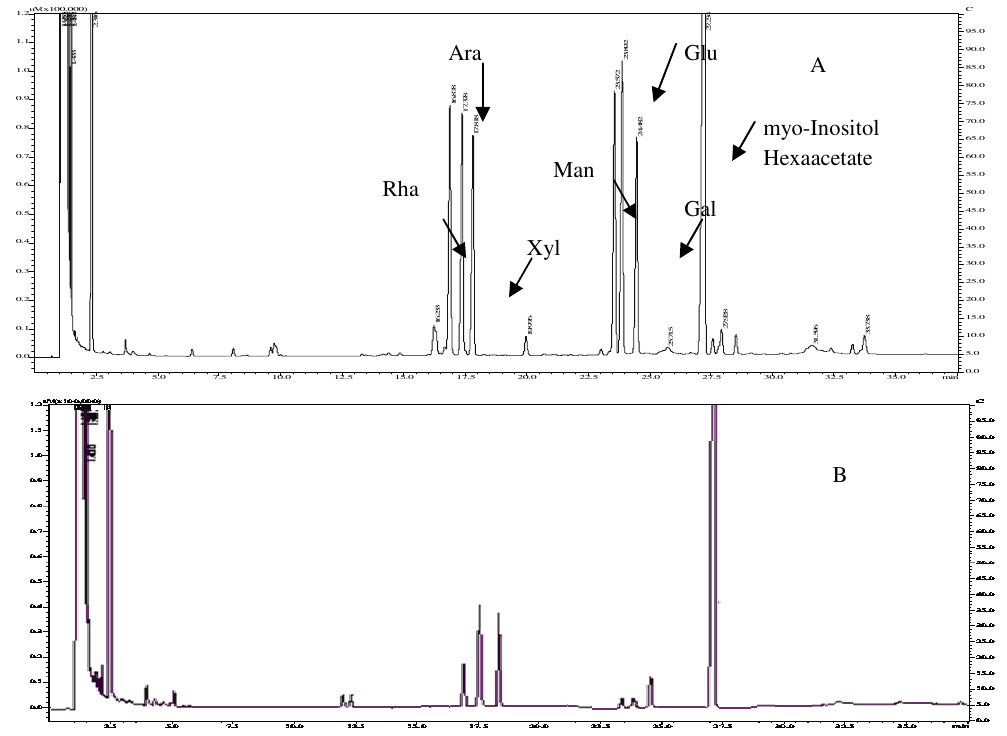
Figure 5. The gas chromatogram of mixed substances and polysaccharide P32 of